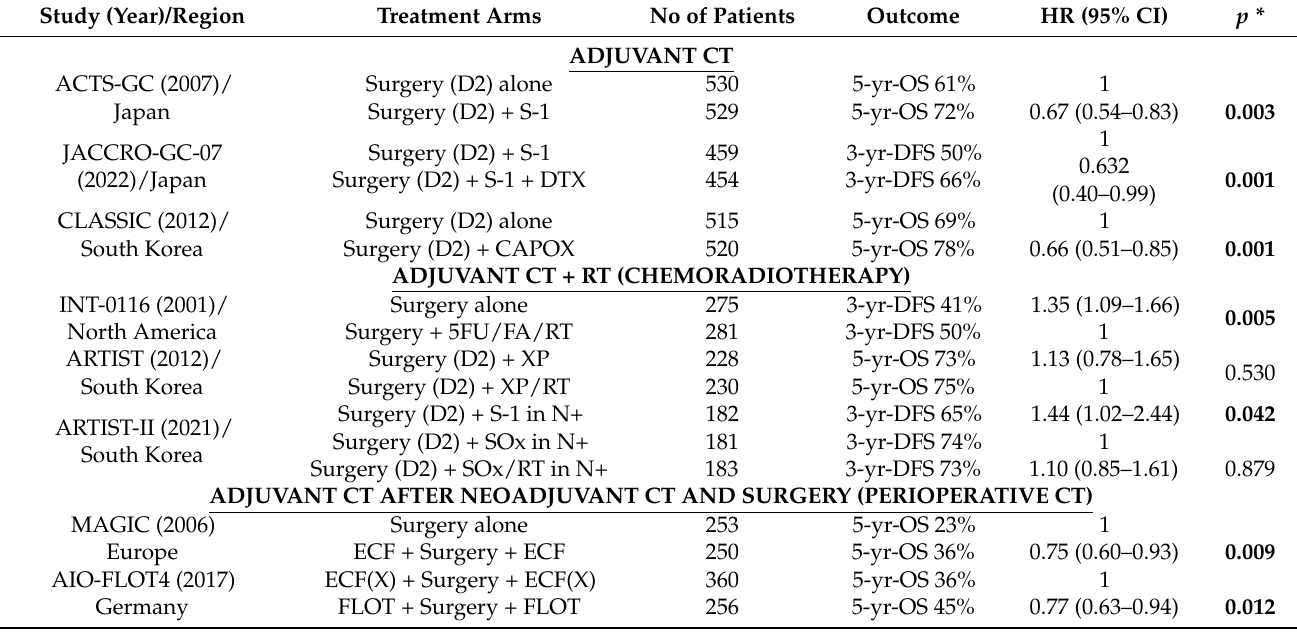
Table 1. Phase III clinical trials guiding the current clinical practice. Treatment Arms No of Patients Outcome HR (95% CI) p